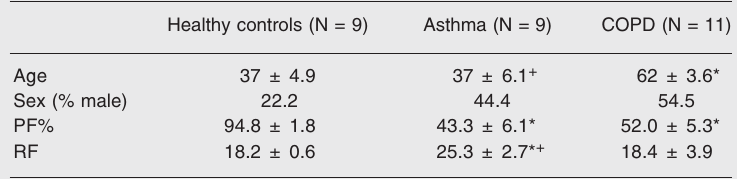
Table 1. Clinical parameters of individuals with asthma and chronic obstructive pulmo- nary disease (COPD). Healthy controls (N = 9) Asthma (N = 9) COPD (N = 11) Age